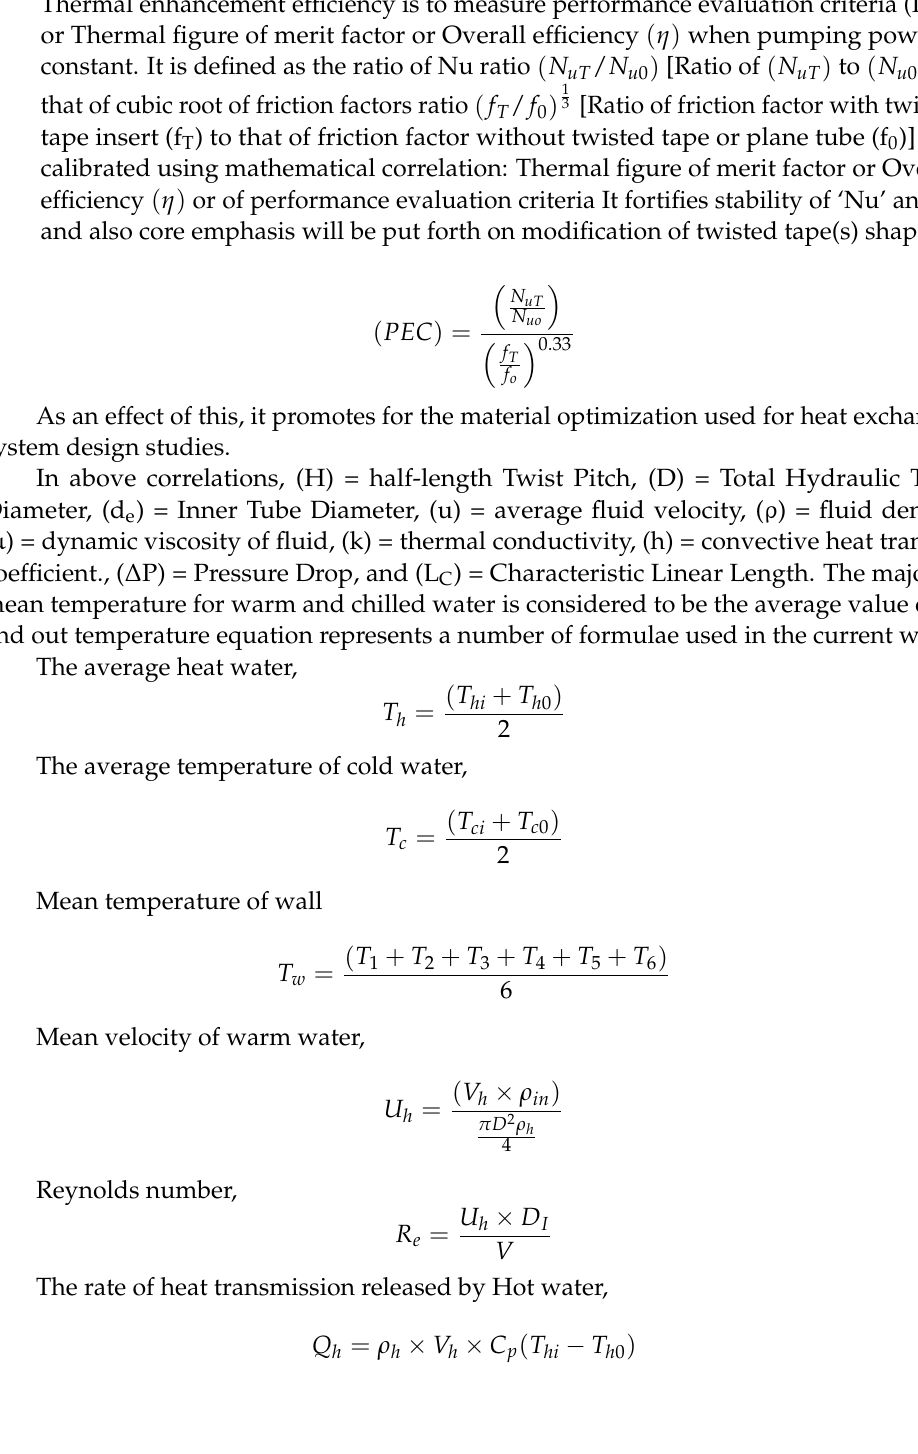
Thermal enhancement efficiency is to measure performance evaluation criteria (PEC) or Thermal figure of merit factor or Overall efficiency ( η ) when pumping power is constant. It is defined as the ratio of Nu ratio ( N uT / N u 0 ) [Ratio of ( N uT ) to ( N u 0 ) ] to 1 that of cubic root of friction factors ratio ( f T / f 0 ) 3 [Ratio of friction factor with twisted tape insert (f T ) to that of friction factor without twisted tape or plane tube (f 0 )] and calibrated using mathematical correlation: Thermal figure of merit factor or Overall efficiency ( η ) or of performance evaluation criteria It fortifies stability of ‘Nu’ and ( f ) and also core emphasis will be put forth on modification of twisted tape(s)